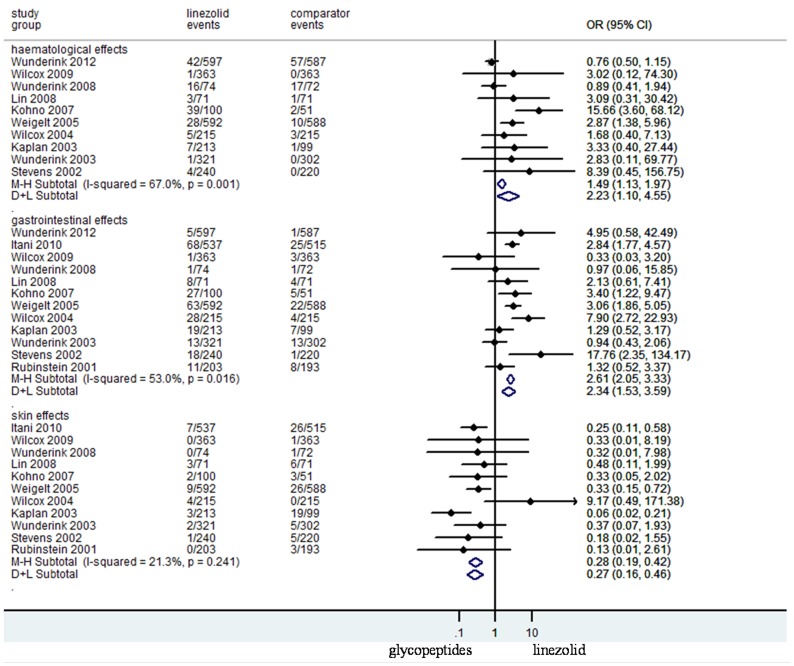
Meta-analyses of haematological, gastrointestinal, and skin adverse effects related to studied regimens.Test of haematological adverse effects for overall effect: Z = 2.56 P = 0.010; test of gastrointestinal adverse effects for overall effect: Z = 7.74 P = 0.000; test of skin system adverse effects for overall effect: Z = 6.27 P = 0.000.